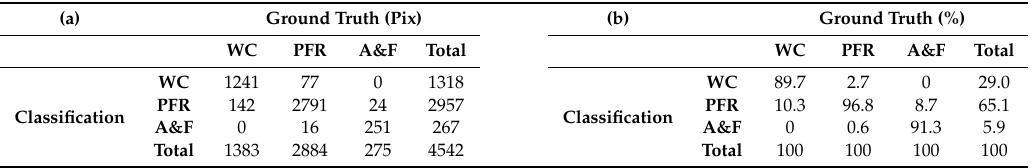
Table 3. Matrices between classification results and field information collected in winter campaigns, expressed in pixels ( a ) and in percentage ( b ). The field data correspond to the evaluation subset and groups information of all RPG sub-regions and all the agricultural years. WC: Winter Crops, PFR: Perennial Forage Resources, A&F: A ff orestations and Forests.